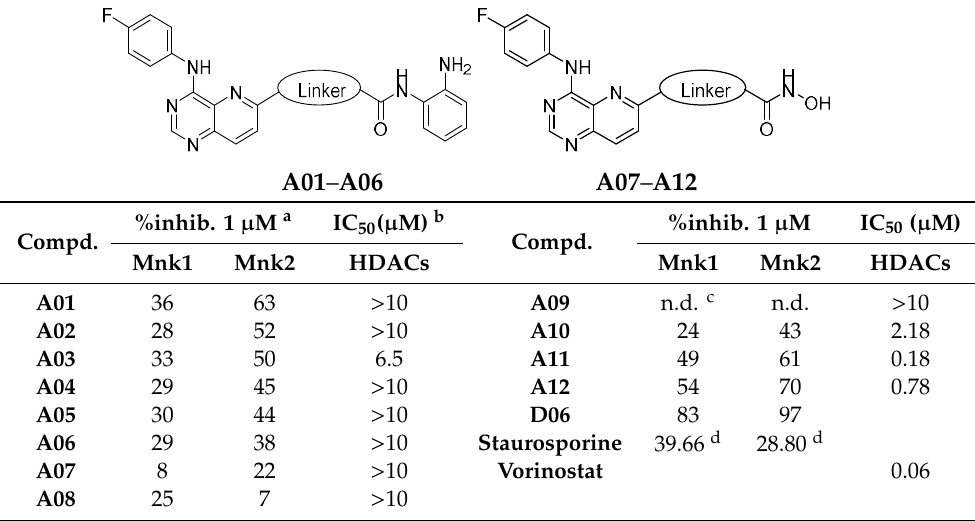
Table 1. In vitro enzymes inhibitory activity of target compounds A01 – A12 .